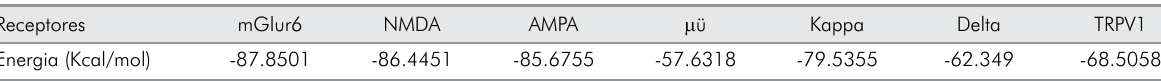
Table. Binding energies of geraniol to receptors.